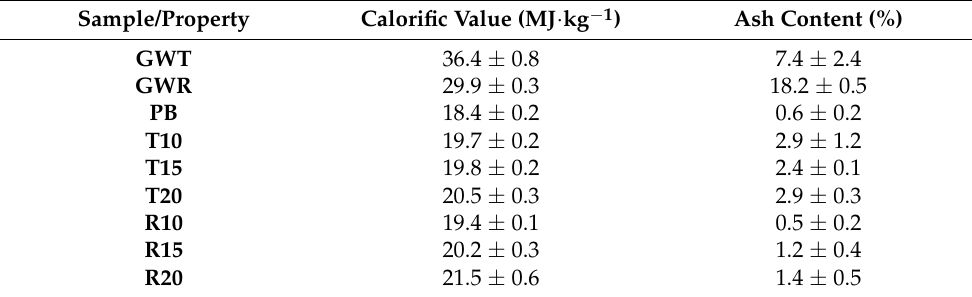
Table 5. Calorific value and ash content of rubber materials and